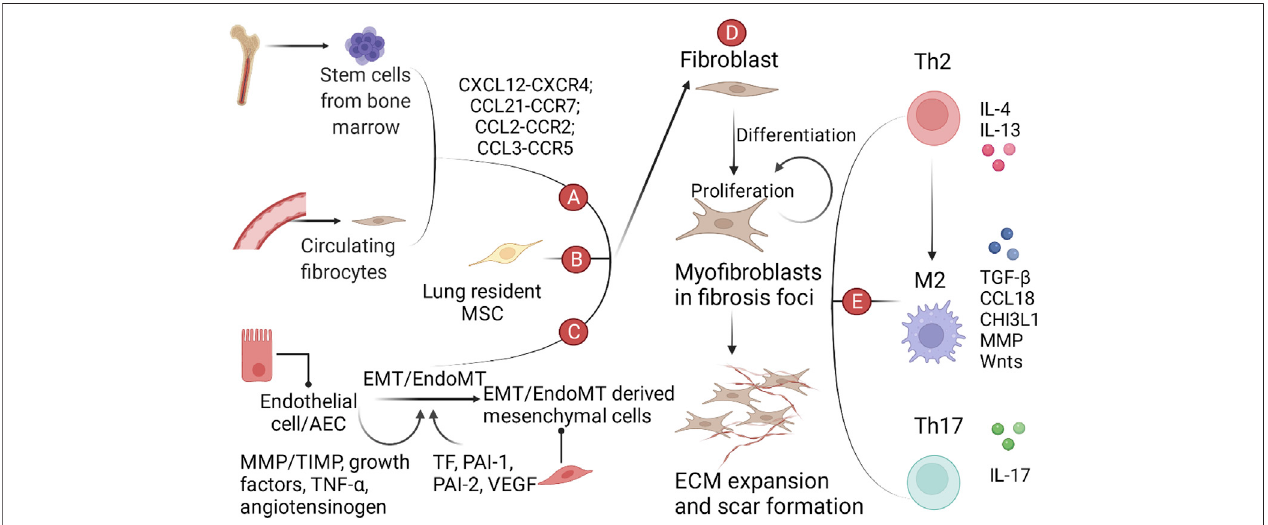
FIGURE 1 | A schematic view of the role of various cells, growth factors and cytokines in IPF. (A) Bone marrow-derived mesenchymal progenitor cells and circulating fi brocytes in the peripheral circulation are recruited to the lung by the chemokine-chemokine receptor axis. (B) Lung resident MSCs. (C) EMT/EndoMT- derived mesenchymal cells. (D) Cells from the above three sources aggregate, proliferate, and differentiate into myo fi broblasts in the lung, ultimately leading to ECM expansion and scarring. (E) Immune cells and cytokines involved in